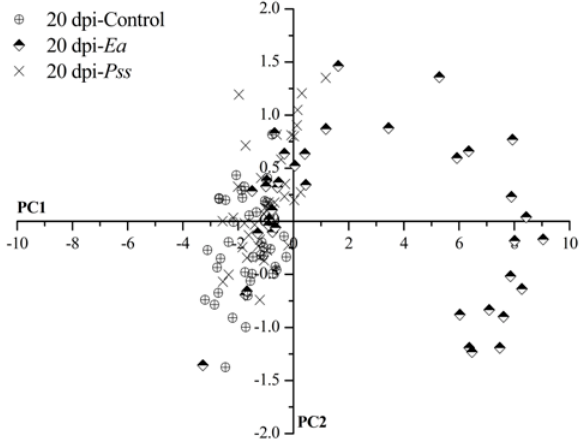
Figure 2. PC1/PC2 scores plot obtained after PCA applied to HR data for pear leaf samples from 20 dpi-control, 20 dpi- Ea and 20dpi- Pss